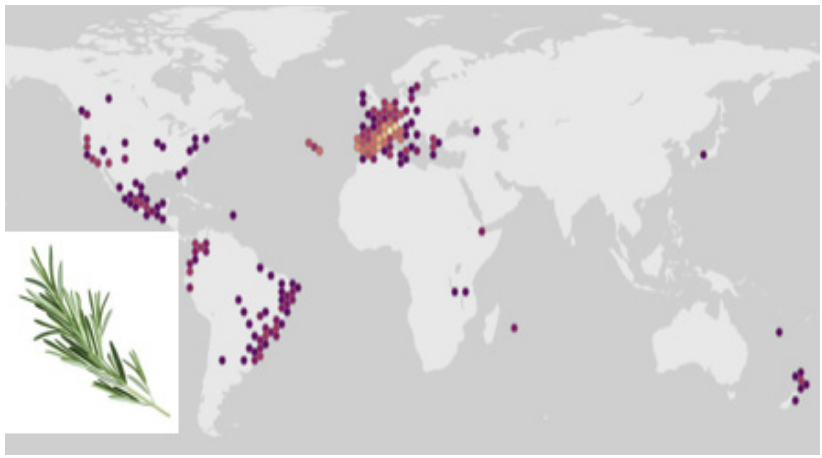
Figure 2. Geographic distribution of Rosmarinus officinalis according to the Global Biodiversity Information Facility (GBIF) [27]. For a better understanding of the graphic, see text. GBIF is an